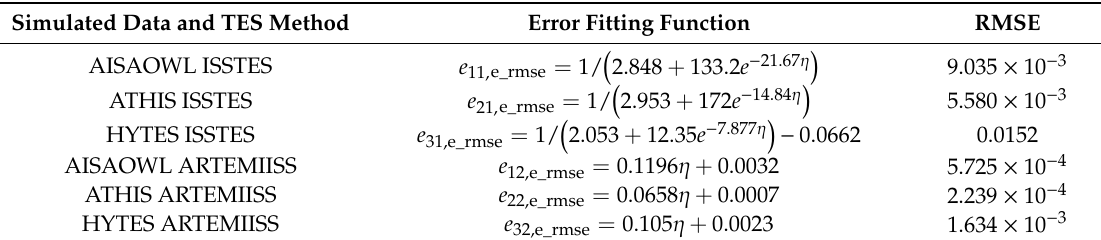
Table 10. The LSE error fitting function about NEDT when center wavelength shift ratio = 0 and FWHM change ratio = 0.